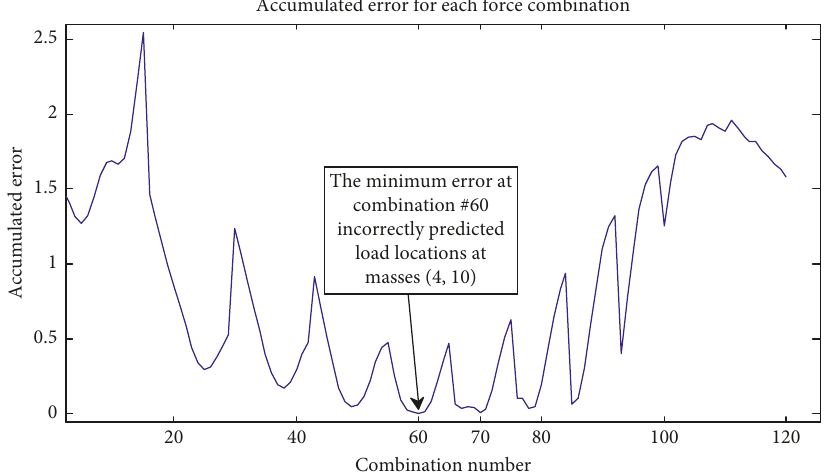
Figure 3: Accumulated error with 5 retained modes and using uniformly distributed sensors.